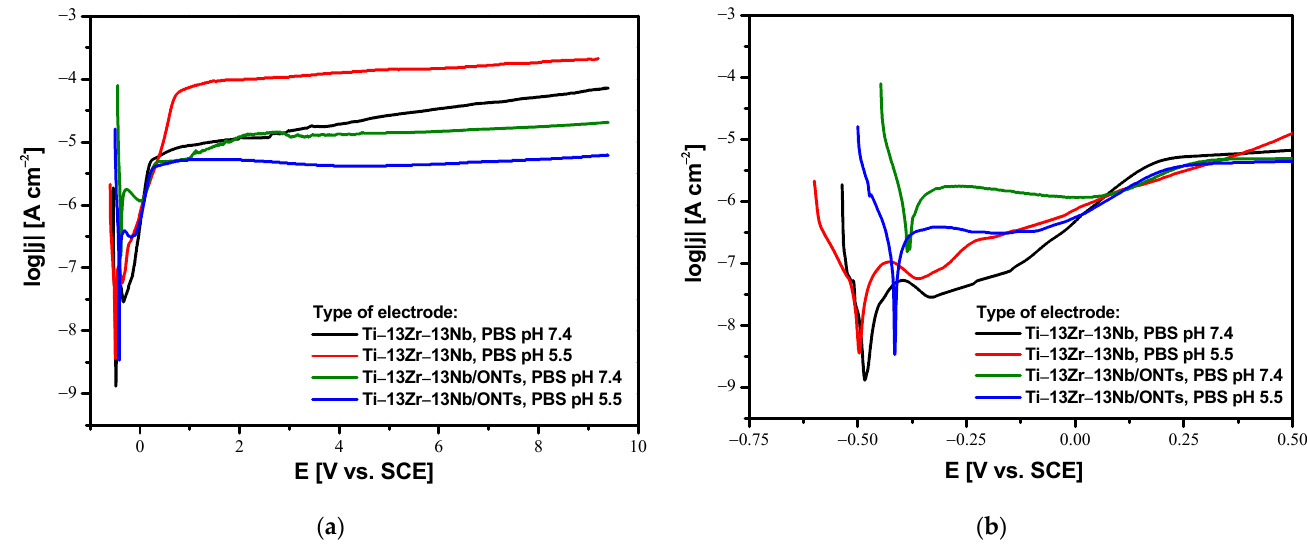
Figure 12. Anodic polarization curves for the Ti–13Zr–13Nb electrode without and with 2G ONTs layer in physiological and acidic PBS at 37 °C: ( a ) In the whole range of tested potentials; ( b ) The inset in the range of potentials corresponding to the cathode ‐ anode transition.